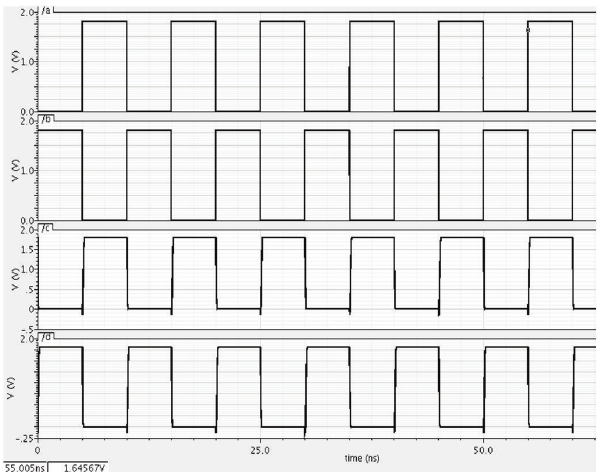
Figure 9: Simulated input and output waveforms of proposed DCVSL circuit using CPTL logic.